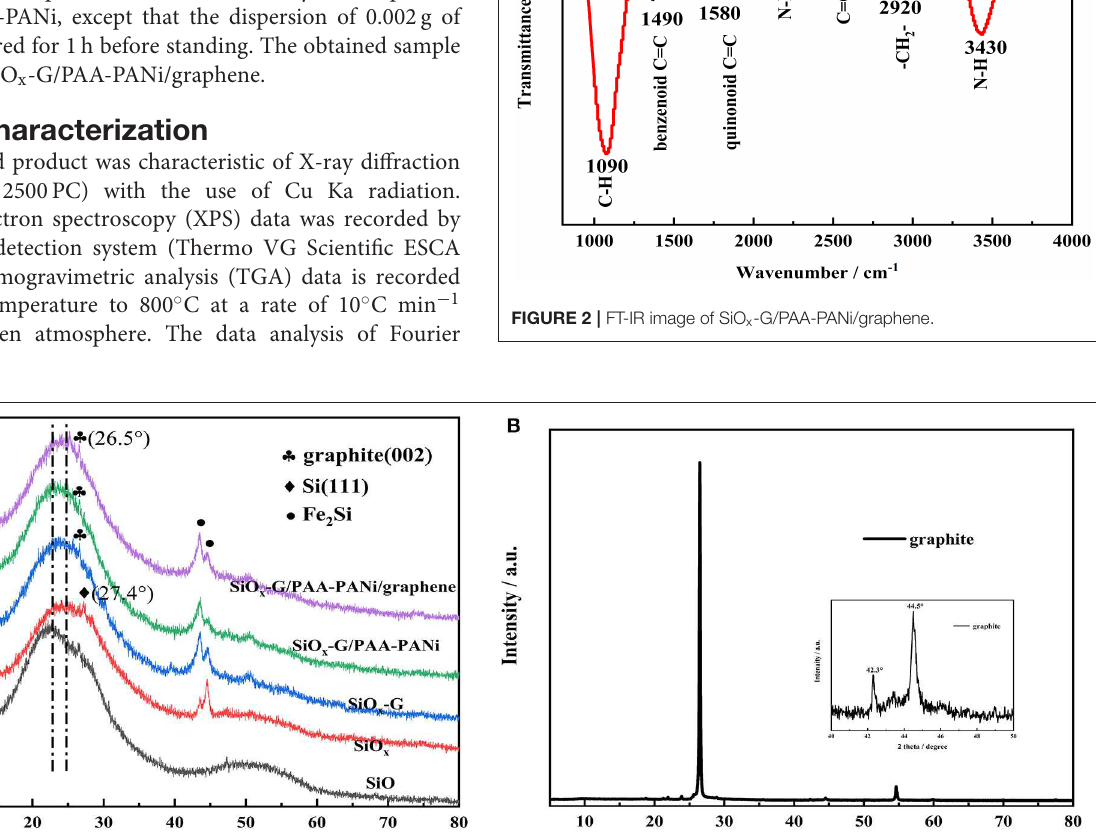
Frontiers in Chemistry |